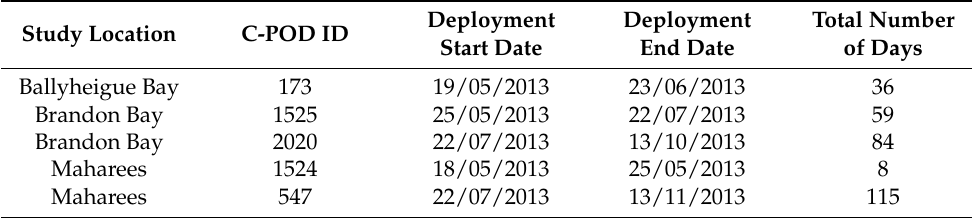
Table 1. Summary of C-POD deployments in Ballyheigue Bay, Brandon Bay and the Maharees. Study Location C-POD